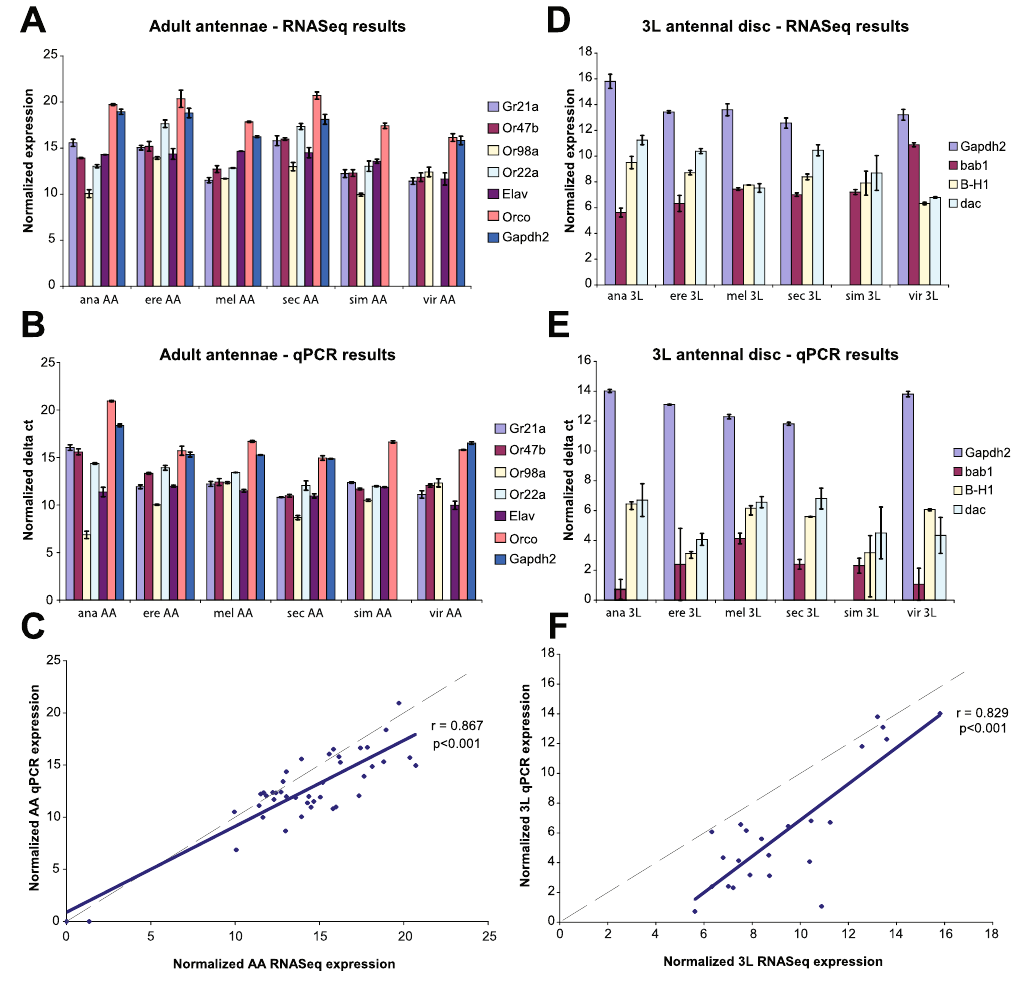
Figure 2. qPCR validation of RNASeq results. (A) RNASeq expression values for select genes from the adult antennae, log normalized against Act5C , and (B) corresponding qPCR delta Ct values for the same genes from the adult antennae, also normalized against Act5C . (C) Plot of normalized RNASeq results versus normalized qPCR results (n = 42). The dotted line indicates where x = y, and the solid line shows a fitted line, with r as Pearson’s correlation coefficient. (D) RNASeq expression values for select genes from the 3 rd instar larval antennal disc, log normalized against Act5C , and (E) corresponding qPCR delta Ct values for the same genes from the 3L antennal disc, also normalized against Act5C. (F) Plot of normalized RNASeq results versus normalized qPCR results (n = 24). The dotted line indicates where x = y, and the solid line shows a fitted line, with r as Pearson’s correlation coefficient. Error bars indicate the 99% confidence